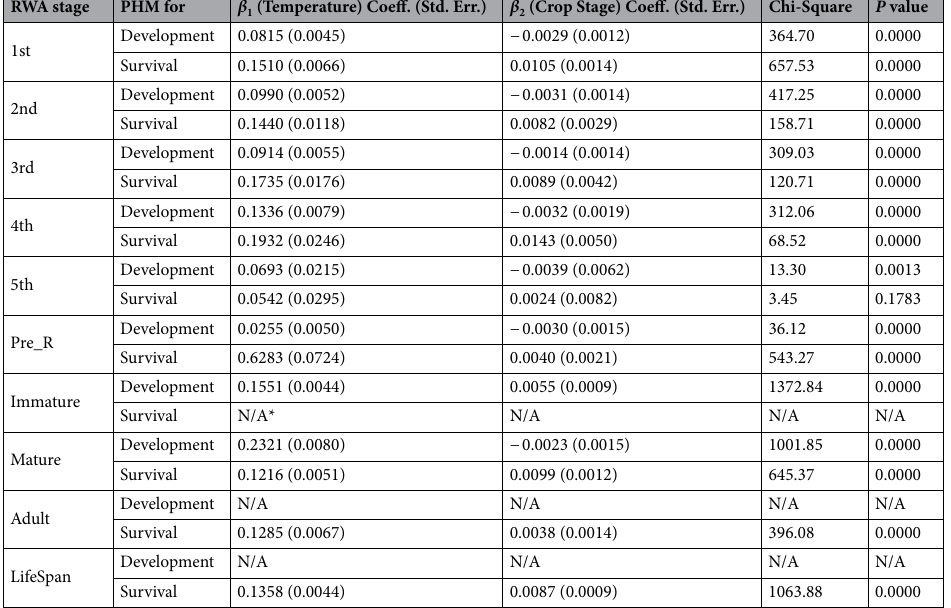
Table 2. Proportional hazards models (PHM) for RWA development and survival. N/A refers to stages where there is only one event (development or survival) that makes sense biologically, or both development and survival refer to the same event. For example, the completion of development of the adult stage is equivalent to the death of the adult. β 1 = ( β 1, β 2 ) are the regression coefficients of Cox’s PHM, as defined in Eqs.